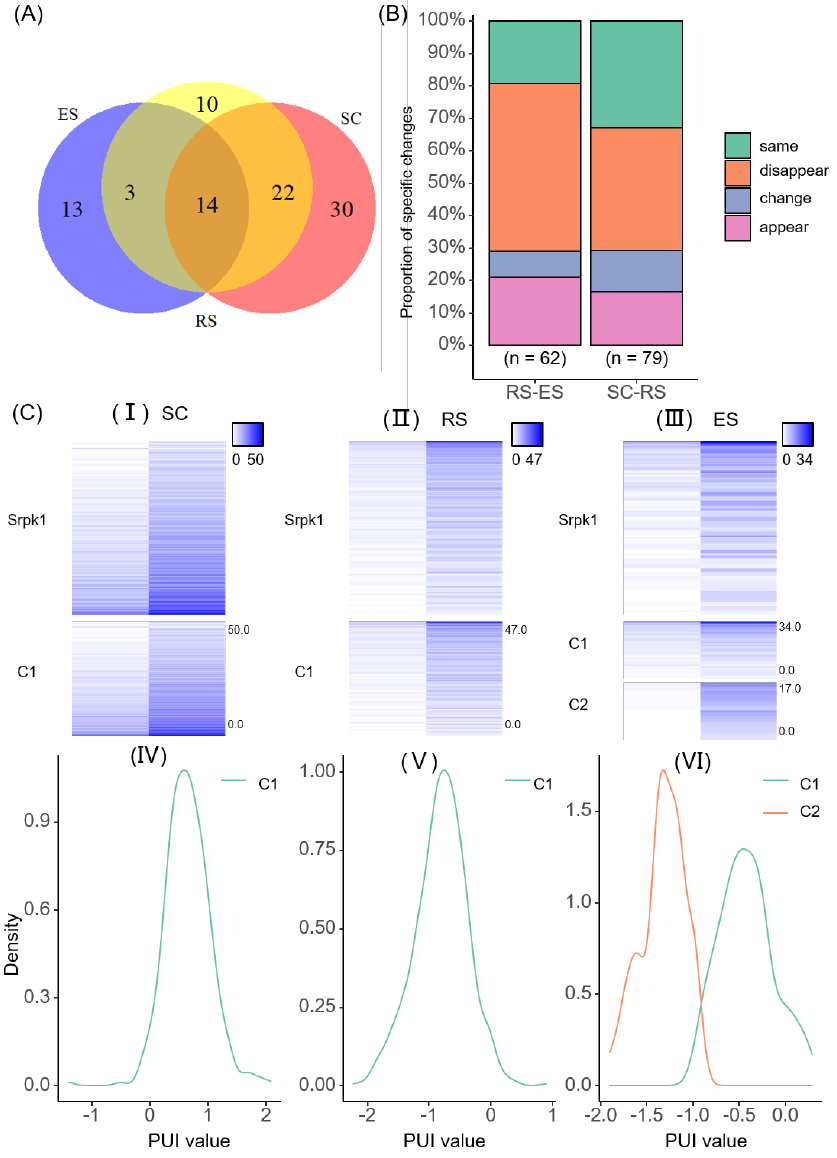
Figure 4. Cell-type-specific modality. ( A ) Statistics on the number of usage patterns genes across different cell types; ( B ) statistics on usage patterns changes of different cell differentiation stages; ( C ) usage pattern changes in Srpk1 gene across different cell types. (I – III) is expression distribution heat maps of the two poly(A) sites of Srpk1 , and the (IV – VI) is the density distribution curve of PUI data of Srpk1 .